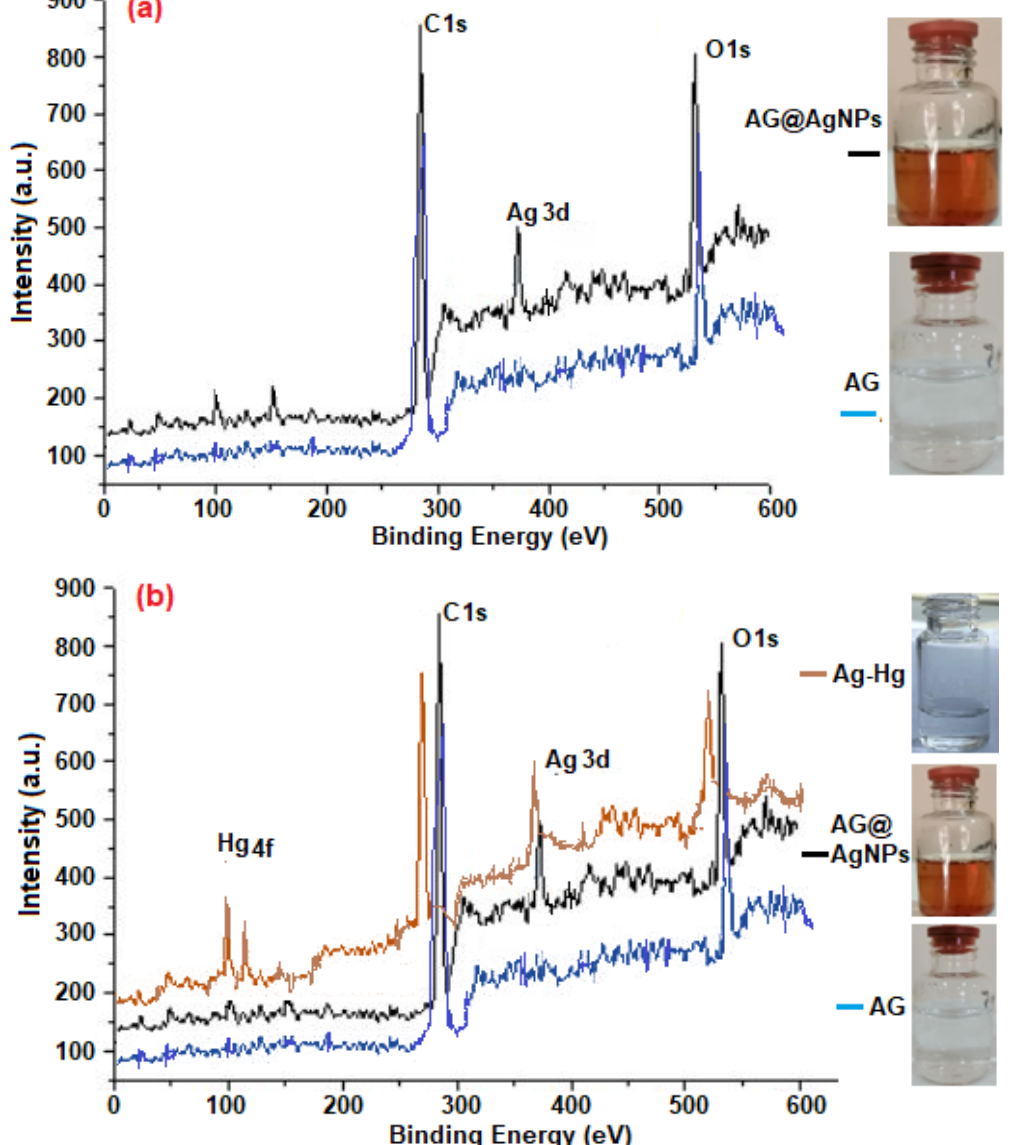
Figure -2. ( a ) XPs spectra of AG and AgNPs@AG; ( b ) XPs analysis of AG, AgNPs@AG, and Ag −